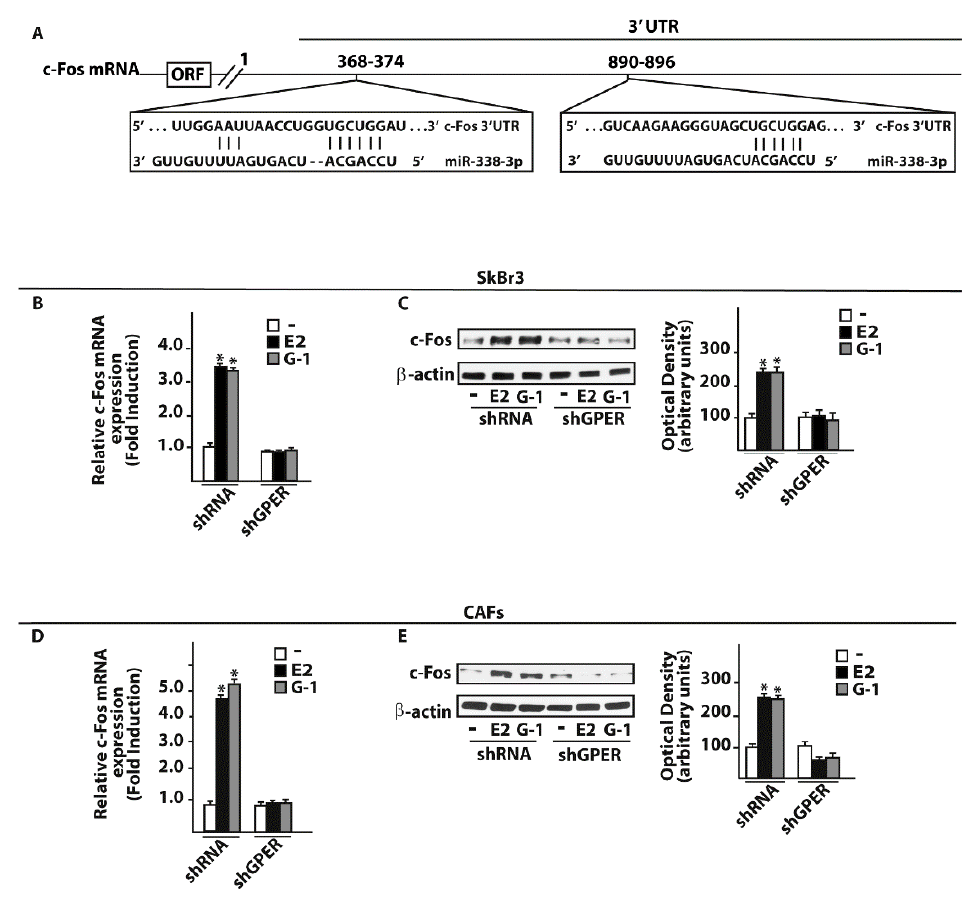
Figure 5. c-Fos is a target gene of miR-338-3p. ( A ) Schematic alignment between the miR-338-3p sequence and the 3’-UTR mRNA region of c-Fos. mRNA expression of c-Fos in SkBr3 cancer cells ( B ) and CAFs ( D ) transfected with shRNA or shGPER for 48 h and then treated for 4 h with 100 nM E2 or 100 nM G-1. Each column represents the mean ± SD of three independent experiments performed in triplicate. c-Fos protein expression in SkBr3 cancer cells ( C ) and CAFs ( E ) transfected with shRNA or shGPER for 48 h and then treated for 4 h with 100 nM E2 or 100 nM G-1. Side panels show densitometry analysis of the blots normalized to the loading control β -actin.